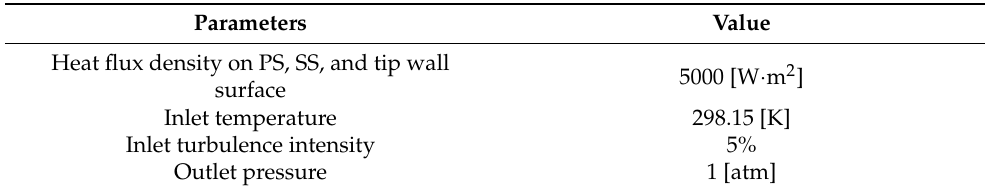
Table 3. The detailed boundary